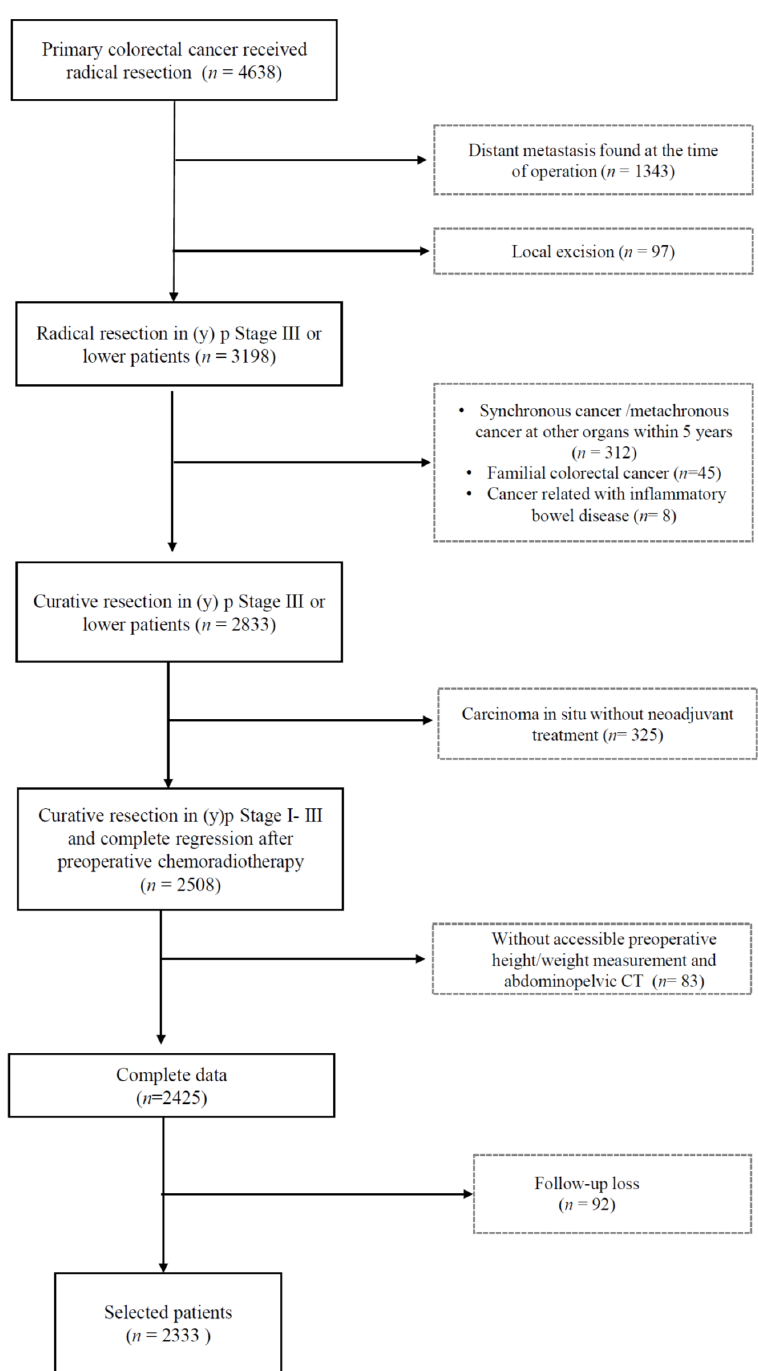
Figure 1. CONSORT diagram. Figure 1. CONSORT Data regarding patients’ sex, age, height, weight, pathological stage, and CT images were obtained from medical records; these were used to calculate BMI and body compo- sition.